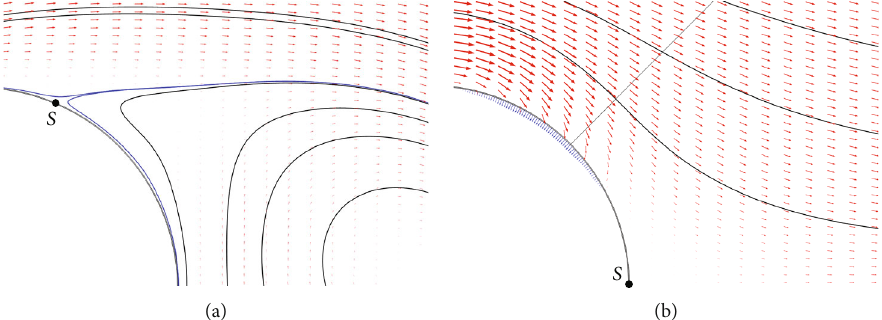
Figure 10: Streamlines and velocity vectors for Re = 180 at (a) t ∗ = 0 and (b) t ∗ = 180 with the optimised 18-segment control. Blue streamlines originate from the curve used for θ s detection, and S marks the measured point of